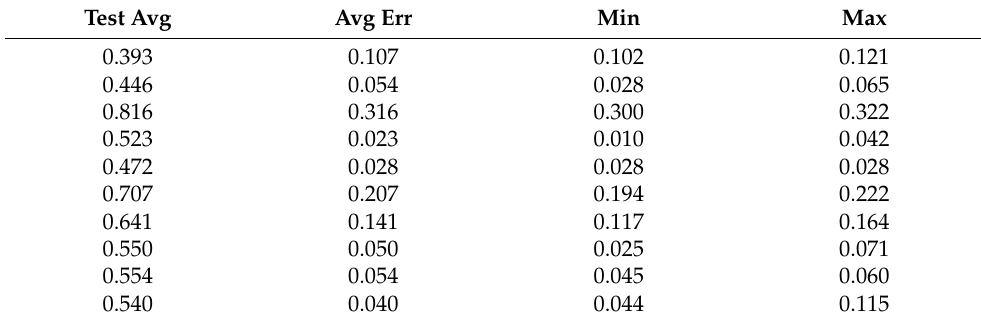
Table A163. Set 3, trials 1–10 data (all 0.5 PR values).